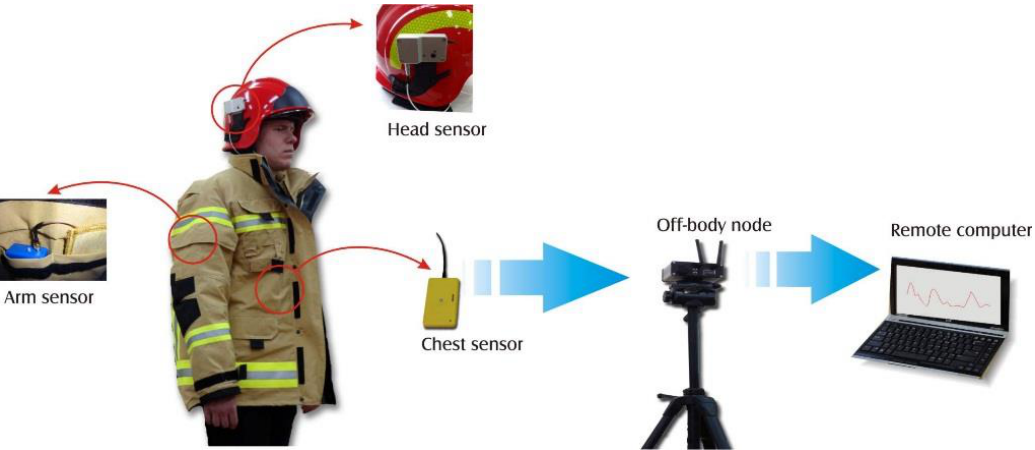
Figure 1. Structure of the wireless body-worn sensor system.